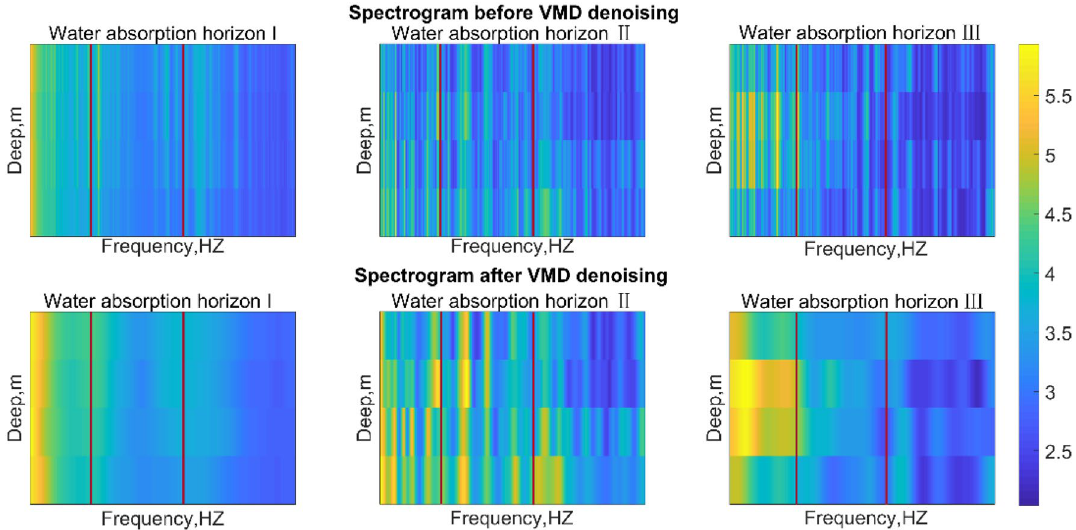
Fig. 7 Spectrum of low frequency region of different absorbent layers